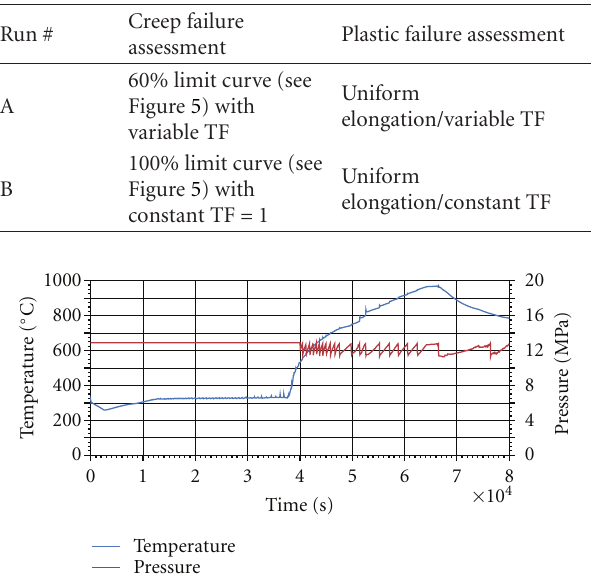
Table 1: Failure assessment criteria.